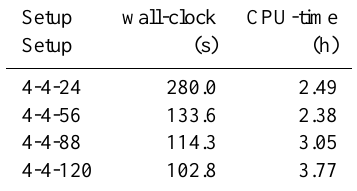
Table 2. Average wall-clock (seconds) and corresponding CPU- times (hours) per simulated hour for the different setups. The CPU- times are the product of the wall-clock times and the number of used cores. In our setup the number of cores equals the number of MPI tasks. Setup wall-clock CPU-time Setup (s) (h) 4-4-24